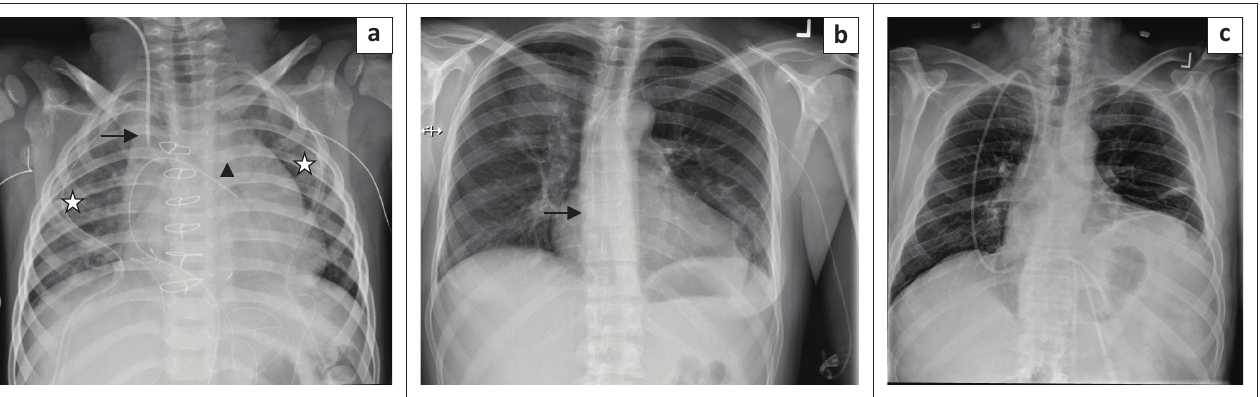
FIGURE 5: (a) Chest radiograph showing a right central venous catheter (arrow) with its end located in the SVC. In addition, bilateral intercostal drainage tubes (stars) and mediastinal drainage tube (arrow head) are noted; (b) chest radiograph showing a left-sided, peripherally inserted central catheter with its tip (arrow) in the right atrium; (c) a tunnelled right central venous